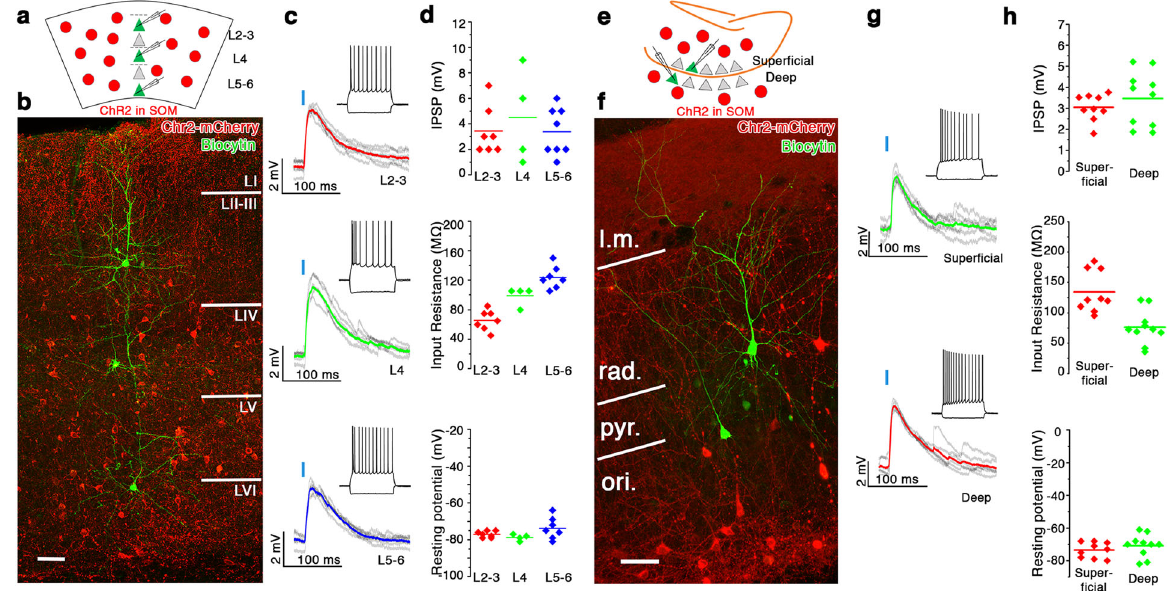
Fig. 2 Pyramidal cells in different layers are equally innervated by SOM + interneurons in the somatosensory cortex and in the hippocampal CA1 region. a Schematic of the experimental con fi guration in the somatosensory cortex: brief (3 ms) whole- fi eld photo-stimulation of ChR2-expressing SOM + cells (red circles) and simultaneous recordings from neighboring pyramidal cells from several layers. b Overview image of three recorded and biocytin- fi lled pyramidal cells in layer III , layer IV , and layer VI (green) in SOM-ChR2 (red) expressing somatosensory cortex (coronal section). c Light-evoked (blue lines represent time of illumination) postsynaptic potential changes in the three recorded cells. Colored lines are the averages of individual (gray) events. Insets: responses to hyperpolarizing and depolarizing current steps of the recorded cells. d Postsynaptic potential (IPSP, top), input resistance (middle), and resting membrane potentials (bottom) of the layer II – III (red), layer IV (green), and layer V – VI (blue) cells. e Schematic fi gure of the experimental con fi guration in the hippocampal CA1 region. f One super fi cial (top right) and one deep pyramidal cell (bottom left, green) surrounded by ChR2-mCherry-expressing cells in SOM-ChR2 animal (coronal section). l.m. lacunosum moleculare, rad. stratum radiatum, pyr. stratum pyramidale, ori. stratum oriens. g Postsynaptic responses of the two recorded cells to 3 ms photo-stimulations. Colored lines are the averages; gray lines are the individual events. Insets: responses to hyperpolarizing and depolarizing current steps of the recorded cells. h Postsynaptic potential (top), input resistance (middle), and resting membrane potentials (bottom) of the super fi cial (red) and deep (green) pyramidal cells. Note that the intracellular solution contained 40 mM CsCl solution, producing depolarizing effect of GABAA receptor opening. L.m. stratum lacunosum moleculare, rad stratum radiatum, pyr stratum pyramidale, ori stratum oriens. Scale bars: 50 μ